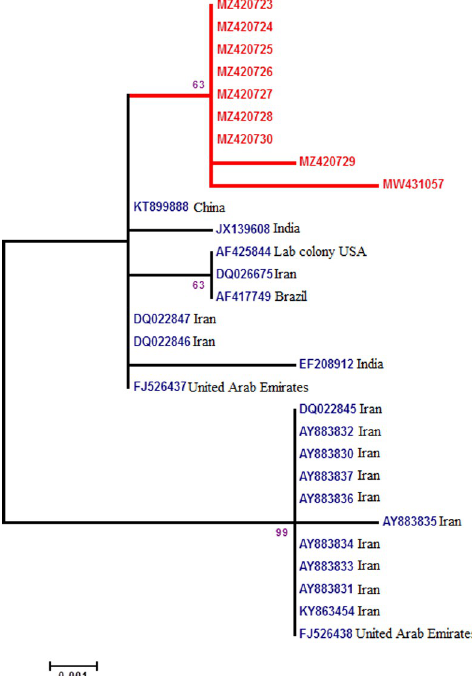
specific to lab strain (S2 Fig). Phylogenetic tree constructed based on An . stephensi COII sequences categorized the sequences in 3 clades (Fig 3). Lab strain sequence was placed in a separate clade together with An . stephensi COII sequences from India and Iran (Fig 3). Phylogenetic analysis of nuclear internal transcribed spacer 2 locus (ITS2). After BLAST, An . stephensi rDNA-ITS2 sequences were extracted from GenBank ( n = 118). These